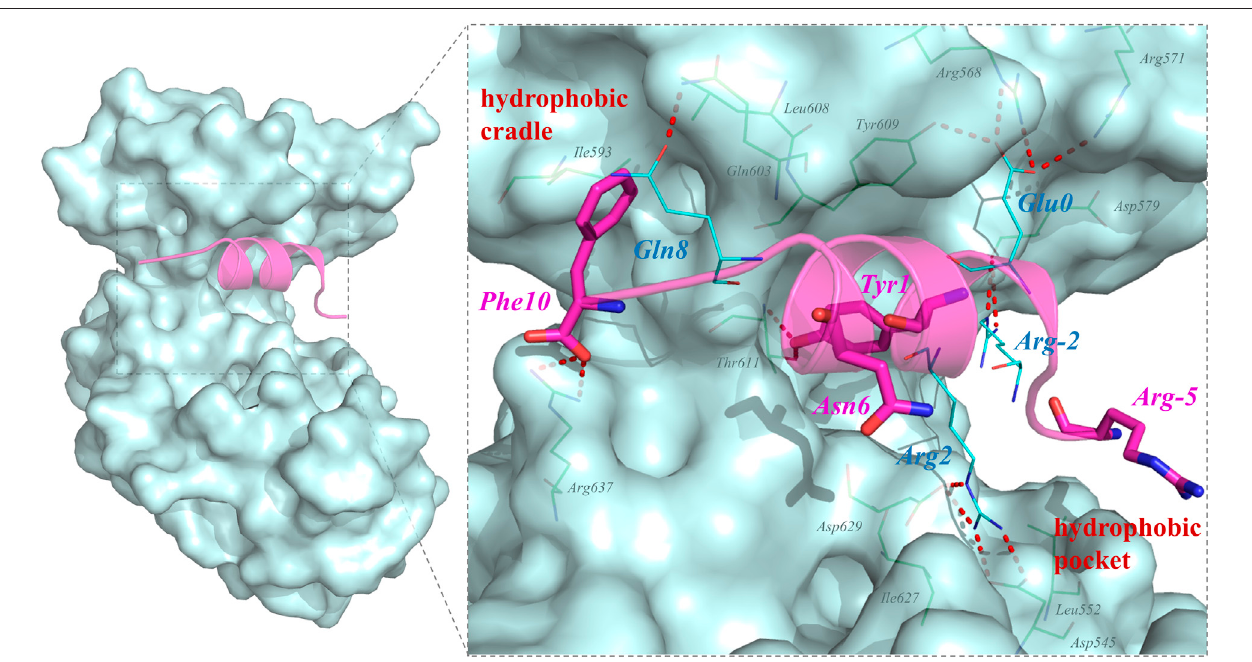
FIGURE 2 | Key residues for the interactions in PSD95 GK/QSF systems during the MD simulations. For the hydrogen bonding interactions, the residues of QSF and GK weredisplayedinlines and colored bycyan and green, respectively. The residues whichweredesigned tomodi fi cation werecolored bymagenta and shown by sticks.